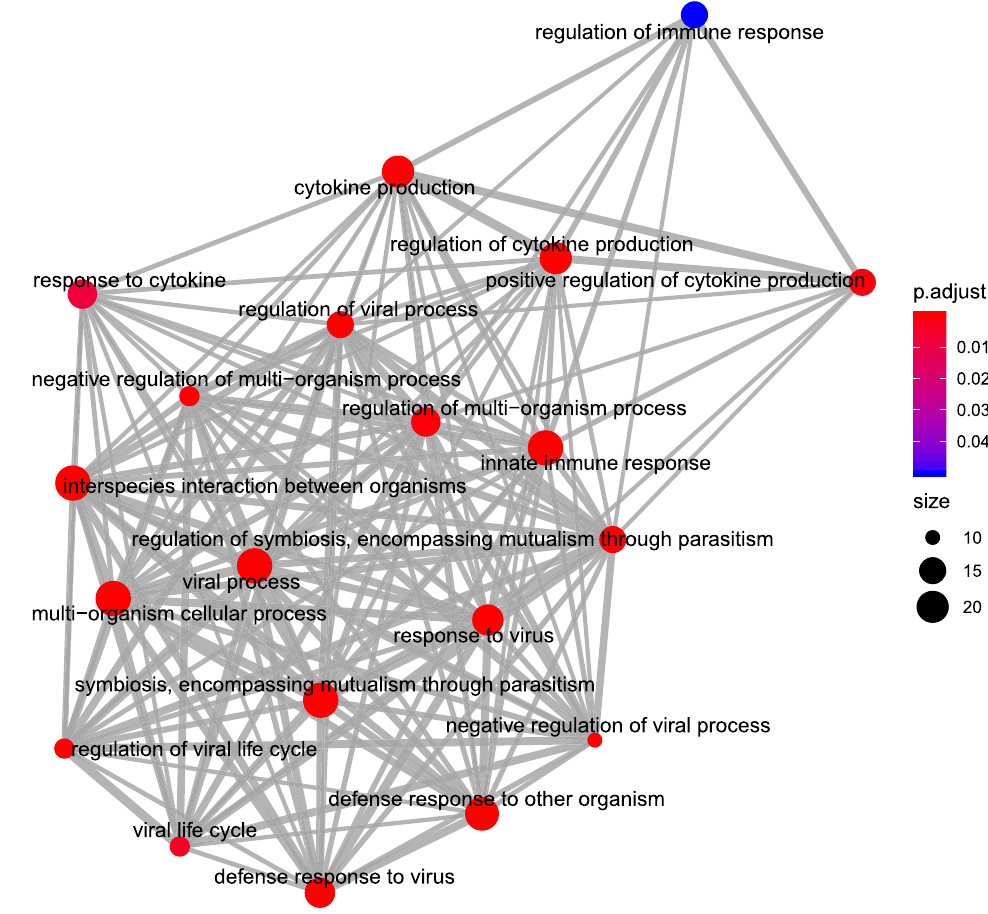
Figure 3. Emap plot of enriched “Biological Process” gene ontology terms ( P < 0.05, FDR < 0.05). This plot was produced in ClusterProfiler 12,15 based on the results of the “EnrichDAVID” 16,17 function. p.adjust =